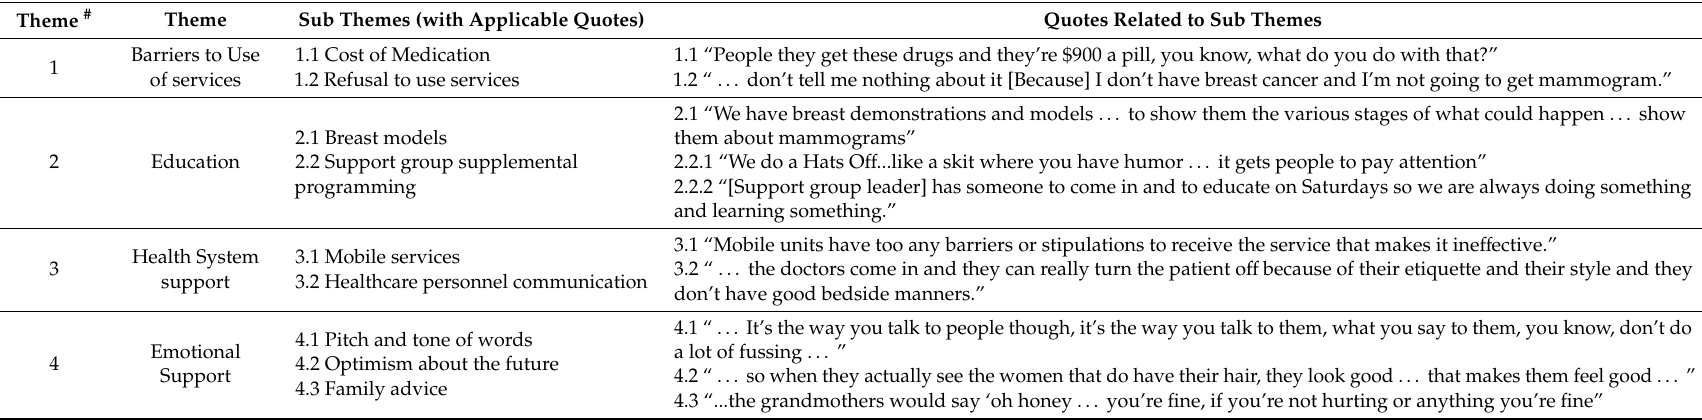
Table 2. Four major themes of African American breast cancer for the Consortium on Health Education Economic Empowerment and Research (CHEER) focus group. Theme